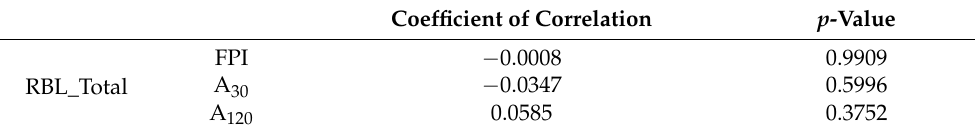
Table 5. Spearman’s correlation analysis of FPI and RBL